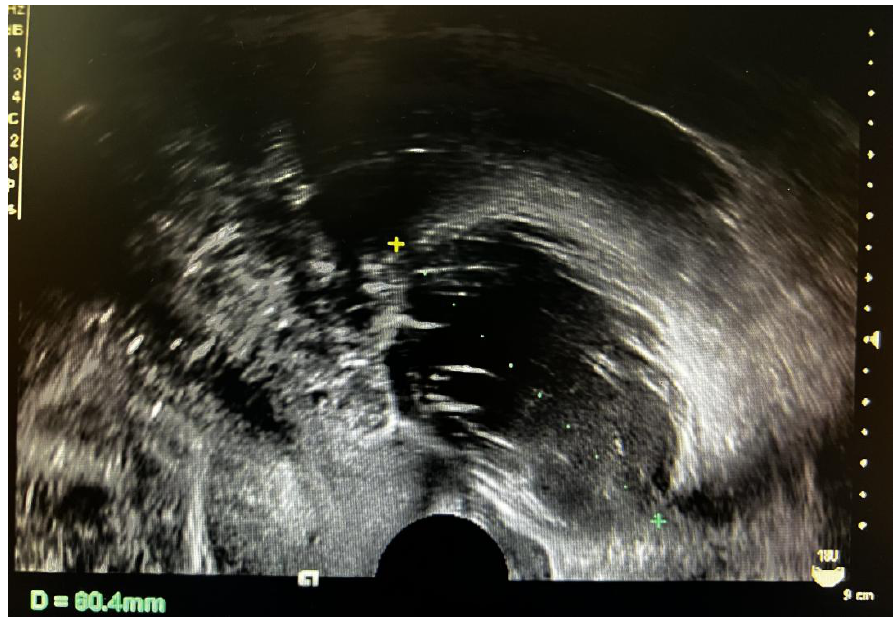
Figure 1. Ultrasound revealed a mixed echogenic zone on the left side of the uterus, 55 × 60 × 46 mm, with a poorly defined boundary, medium hyperechogenic mass in the inner part, 21 × 12 × 18 mm, and sparse color blood flow on the surface and inside.